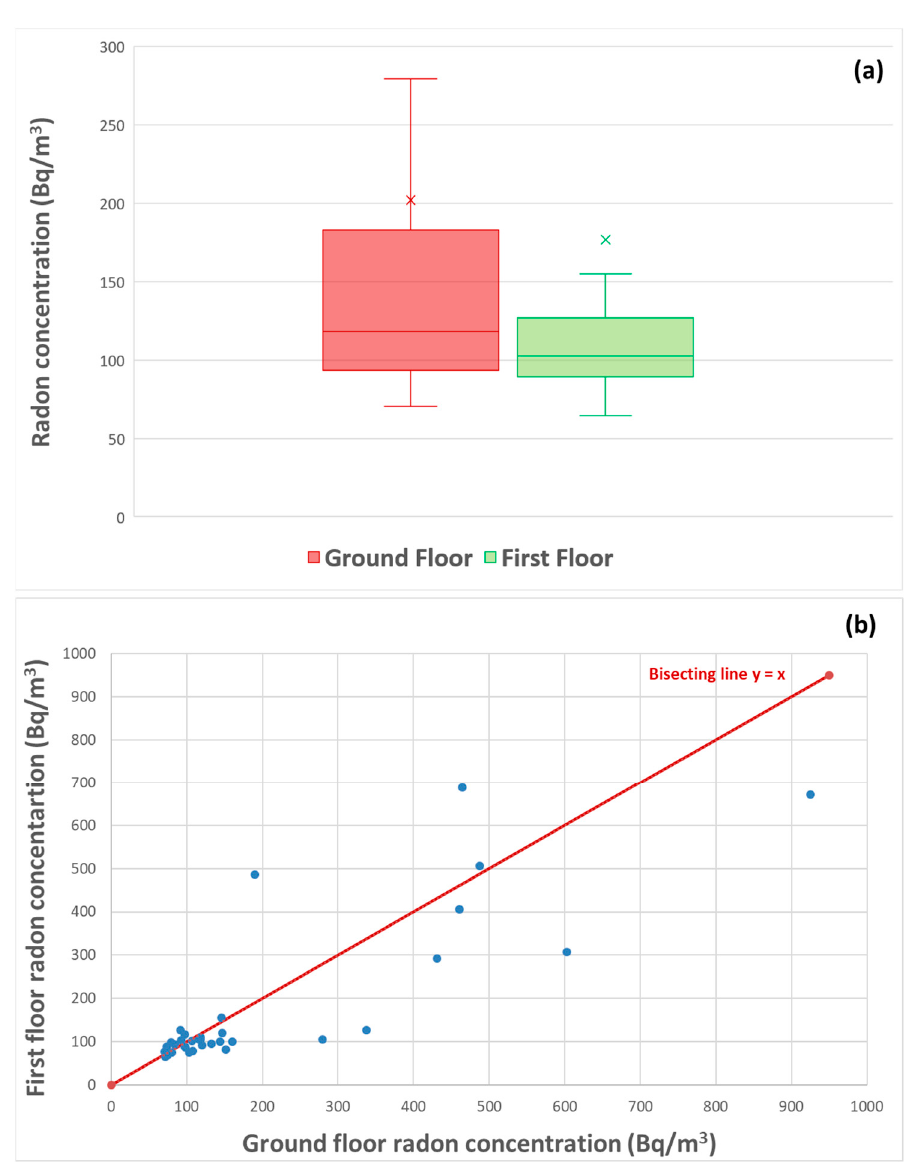
Figure 5. Box plot of annual radon activity concentrations for ground floor and first floor (belonging to the same building) without outliers for a better visual (the x symbol represents the AM) ( a ). The differences between the two distributions of values are statistically significant (W-test p = 0.043). First floor radon activity concentration versus ground floor radon activity concentration ( b ); the continuous line is the bisecting line.